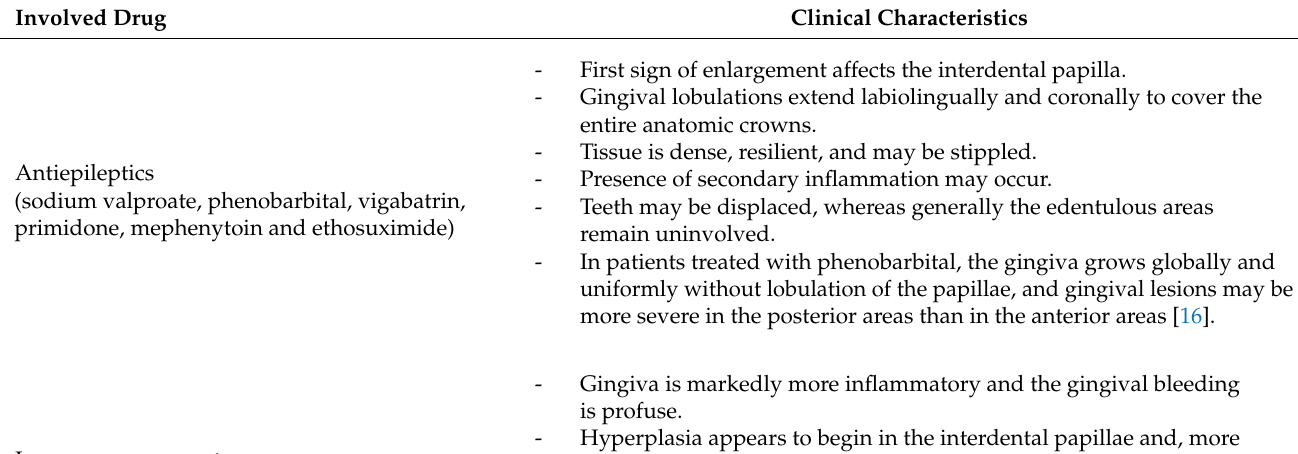
Table 1. Clinical characteristics of Drug Induced Gingival